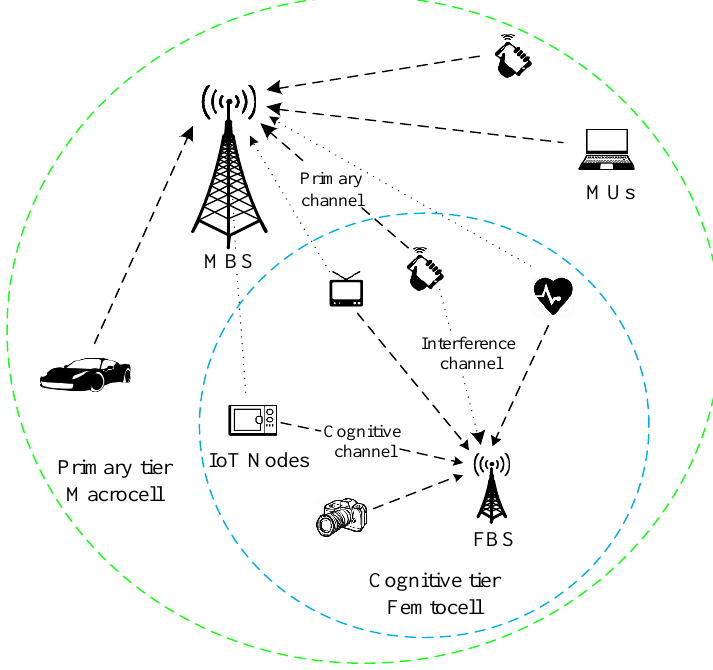
Figure 1. The two-tier cognitive network with coexisting macrocell and femtocell.